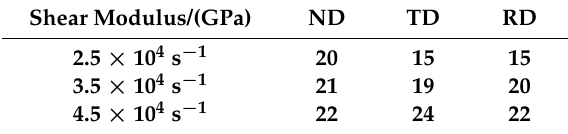
Table 3. The shear modulus of aluminum alloy 7050-T7451 at different strain